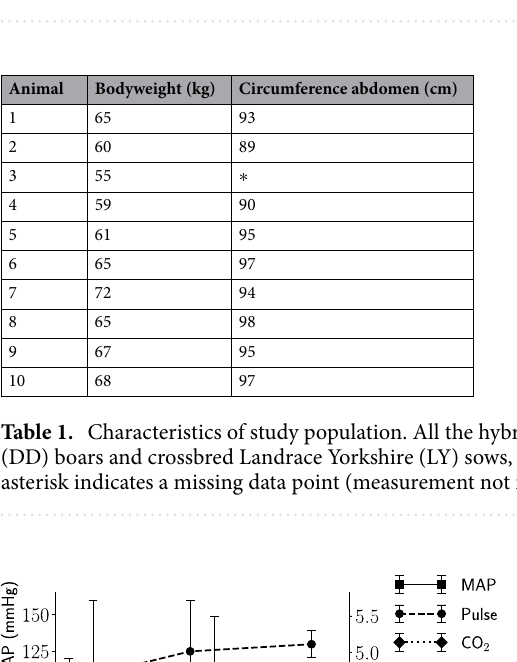
Figure 1. Ultrasound image showing hemoperitoneum in the right upper quadrant of a pig. The two white thin arrows ( a ) show accumulated blood around the liver. The thick white arrow ( b ) is the tip of the liver and the two ribs are marked with “R”.